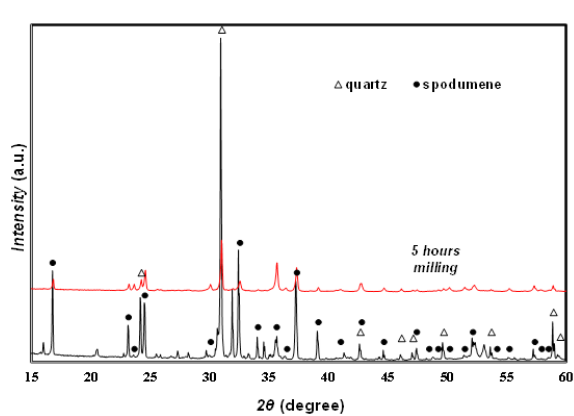
Fig. 1 . XRD pattern of lepidolite concentrate (as starting material) and the lepidolite concentrate after 5 h milling.